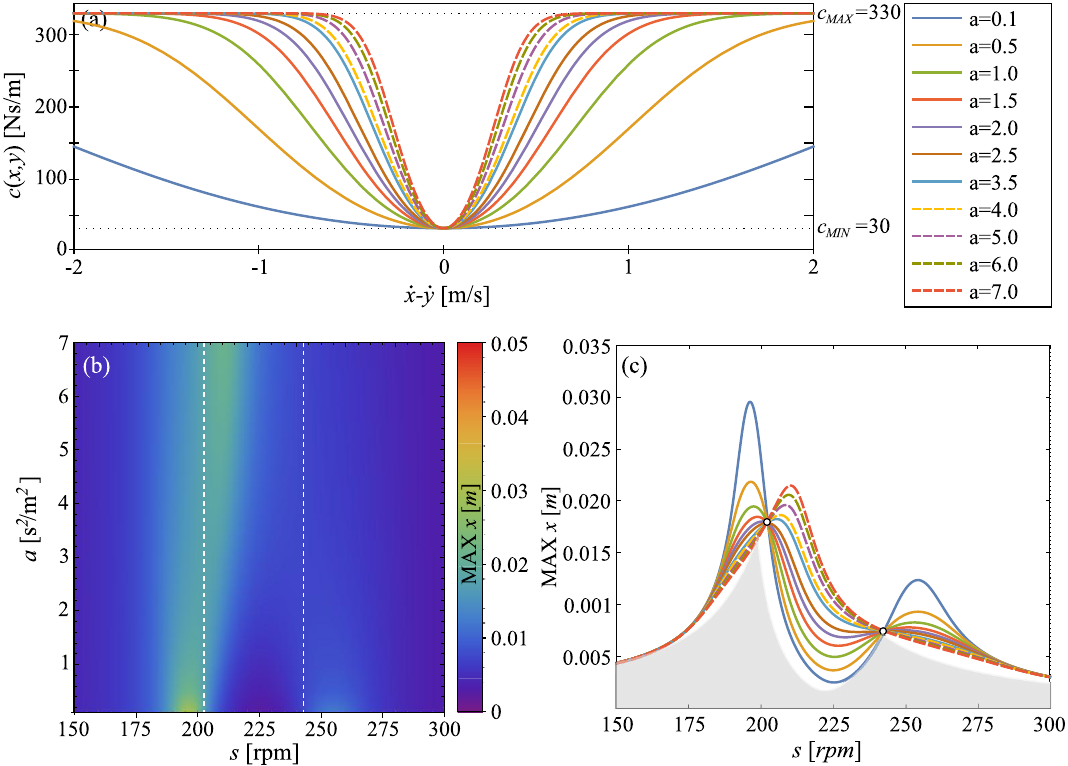
Figure 4. In panel ( a ) we show the damping functions c ( ˙ x , ˙ y ) (Equation (4)) for selected values of a . In panel ( b ) we show two dimensional plot of maximum amplitude of damped system (max x [ m ] ) in two parameters space: a and s . The last panel ( c ) shows eleven exemplary FRCs of damped